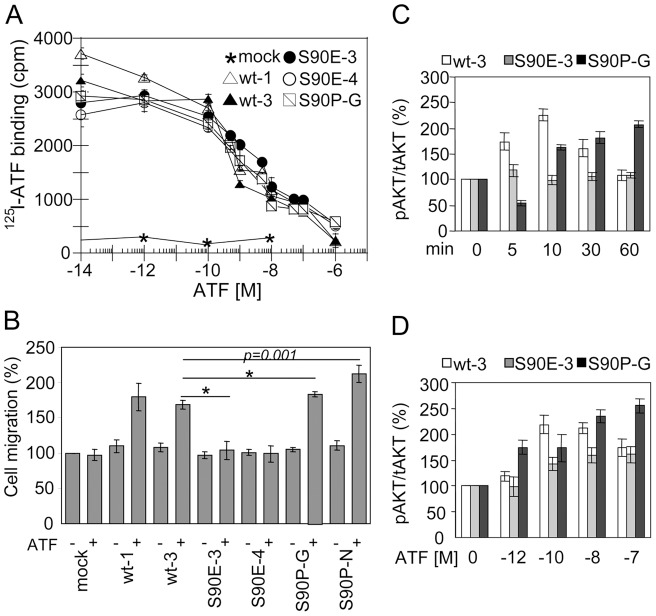
uPARS90E and uPARS90P retain the ability to bind to ATF. A. Transfected 293 clones were grown adherent (2×105cells/well) on 24-multiwell plates. 125I-ATF (150,000 cpm/sample) was incubated with cells, in the presence of increasing concentrations of unlabeled ATF for 3 hours at 4°C and cell surface-associated radioactivity was determined. Data represent the mean of specific binding ± SD of three independent experiments performed in duplicate. B. Directional cell migration of the indicated transfected 293 clones toward 10 nM ATF. The extent of migration is expressed as percentage of cell migration of 293/mock cells assessed in the absence of ATF, considered as 100%. Data represent the mean ± SD of three independent experiments in triplicate. *: p<0.001. C–D. Whole cell lysates(50 µg/sample) from cells exposed to ATF for the indicated times (C) or concentrations (D) immunoblotted with anti-phospho-AKT Ab (pAKT) and then with anti-Akt mAb (tAKT). Quantitative assessment of the pAKT and tAKT content of each sample was performed using NIH Image 1.62 software. Data are means of three experiments, with SD indicated by error bars.